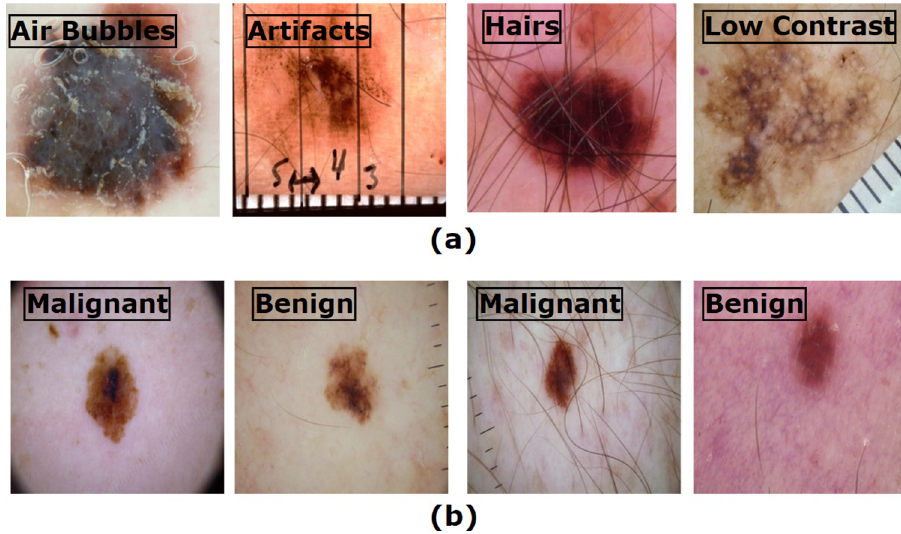
Fig 1. Automatic recognition of skin cancer is impeded by various factors. (a) represents some interferences with important features (b) shows the similarity between benign and malignant lesions.